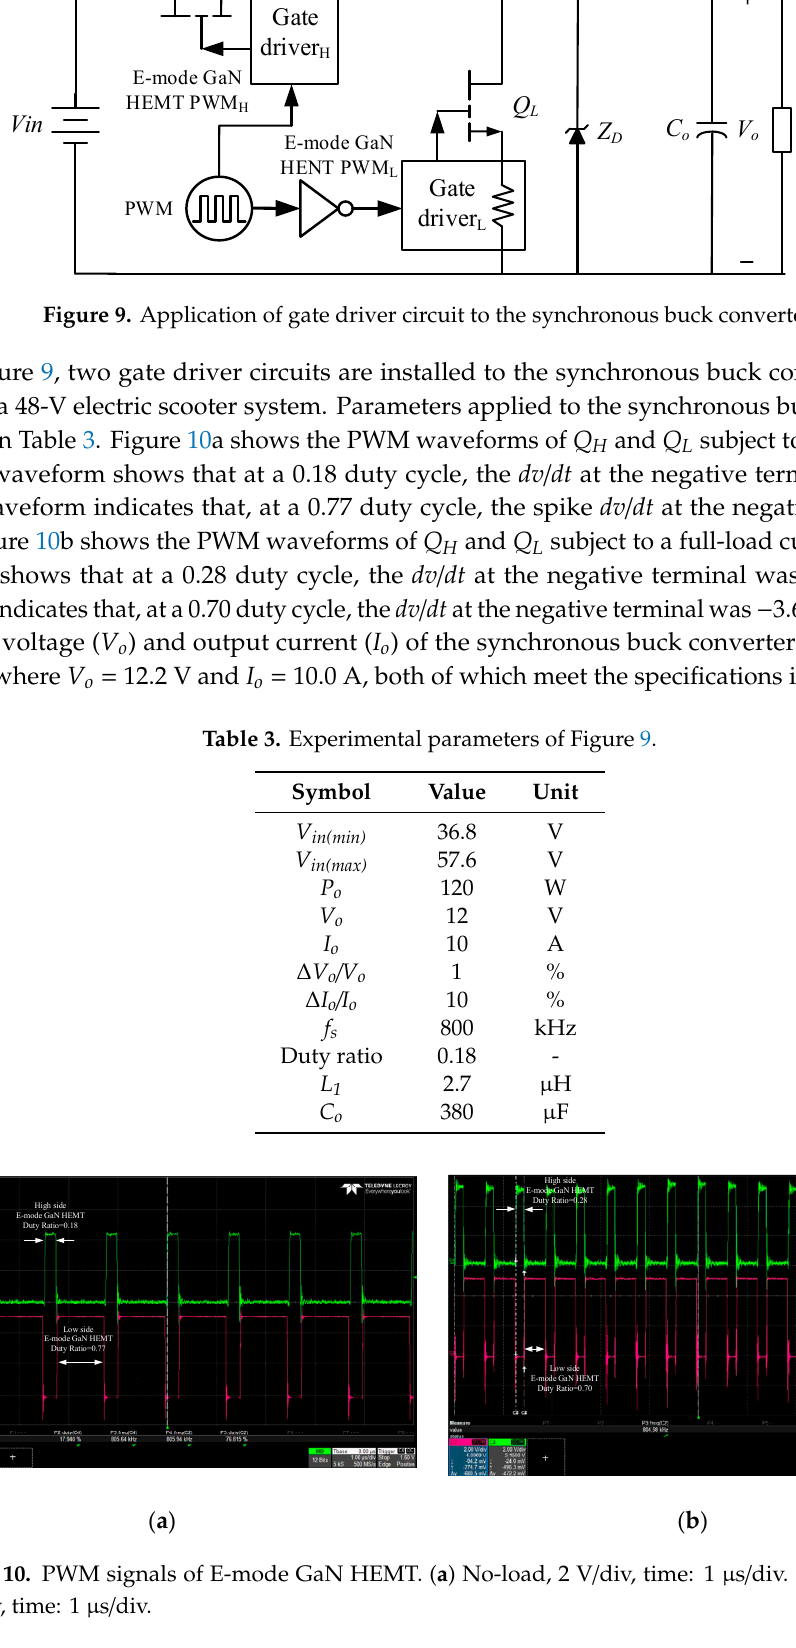
Figure 8. Block diagram of the gate driver circuit.